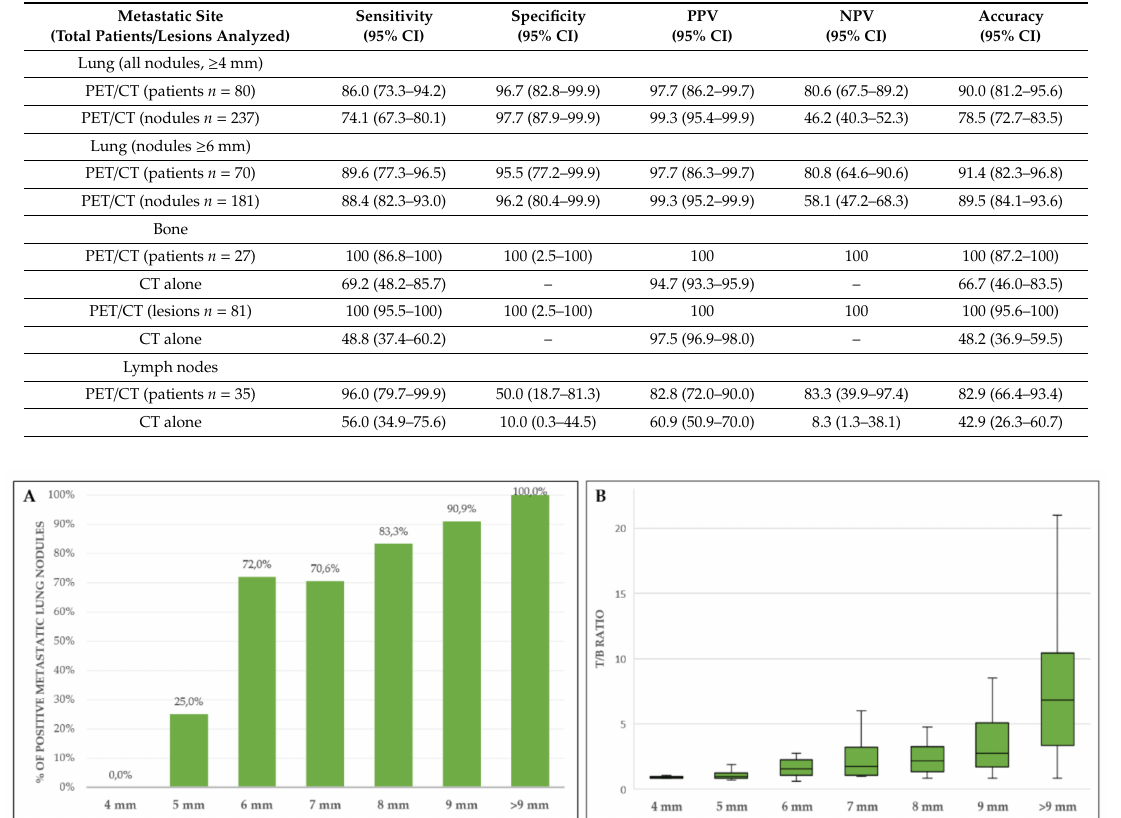
Figure 2. ( A ) Percentage of metastatic lung nodules showing a target-to-background (T / B) ratio > 1.2; ( B ) trend of T / B ratio according to dimensions of metastatic nodules. Boxplot shows interquartile range (box), median (line within the box) and data range (vertical